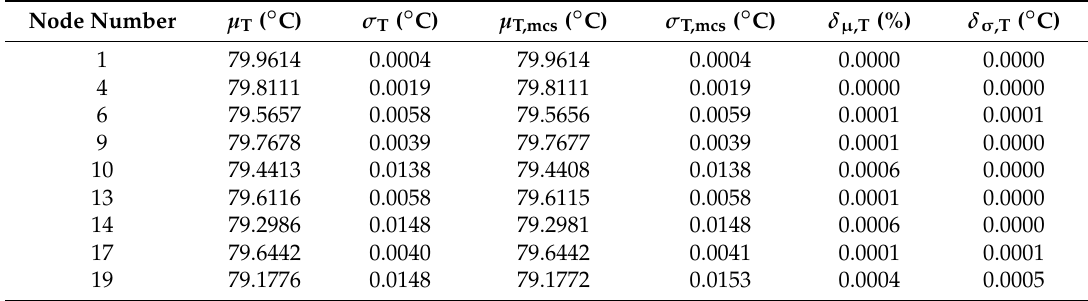
Table 2. Typical mean and standard deviations of node temperature. (Test 1: L = 300 m; µ ϕ = 0.5 MW; σ ϕ = ±10%).